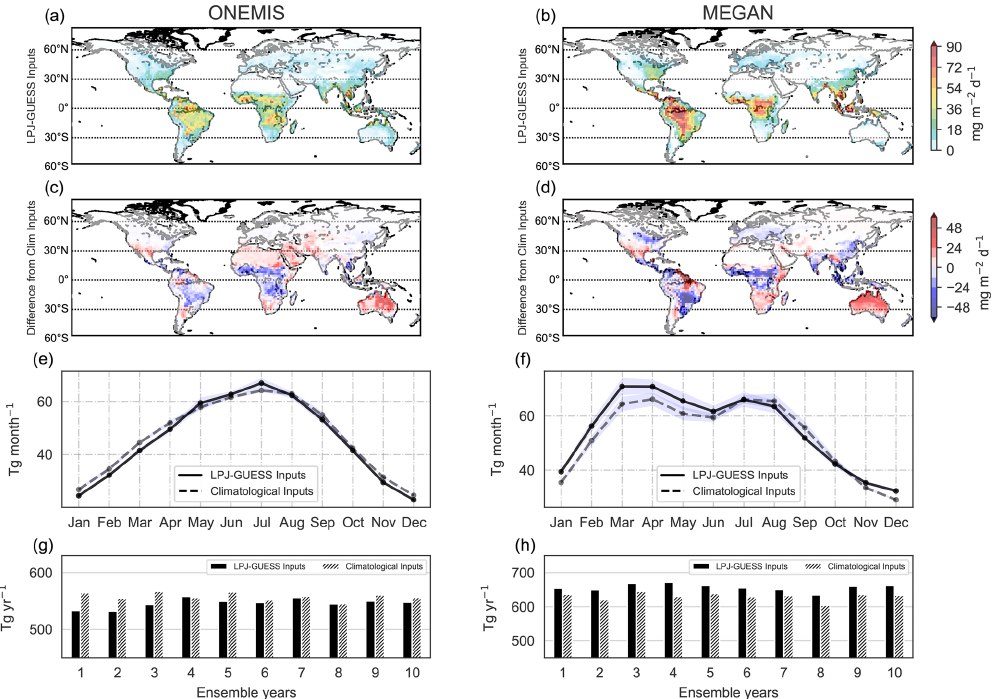
Figure 8. Spatial distribution of monthly isoprene emissions (mgm − 2 d − 1 ) averaged over 10 ensemble years with LPJ-GUESS vegetation inputs from ONEMIS and MEGAN (panels a and b ). Panels (c) and (d) show the difference in the emission flux compared to emissions from ONEMIS and GUESS with climatological vegetation inputs. The temporal profile of isoprene global totals in teragrams per month are depicted in panels (e) and (f) , and global annual totals (Tgyr − 1 ) for 10 ensemble years are shown in panels (g) and (h)